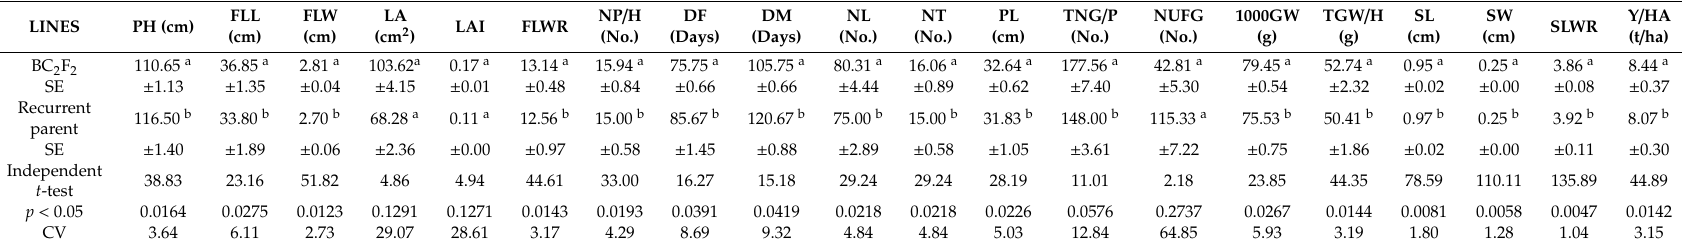
Table 7. Descriptive t -test and co-e ffi cient of variation for mean comparison between the selected improved BC 2 F 2 lines and their recurrent (recipient) parent using independent t